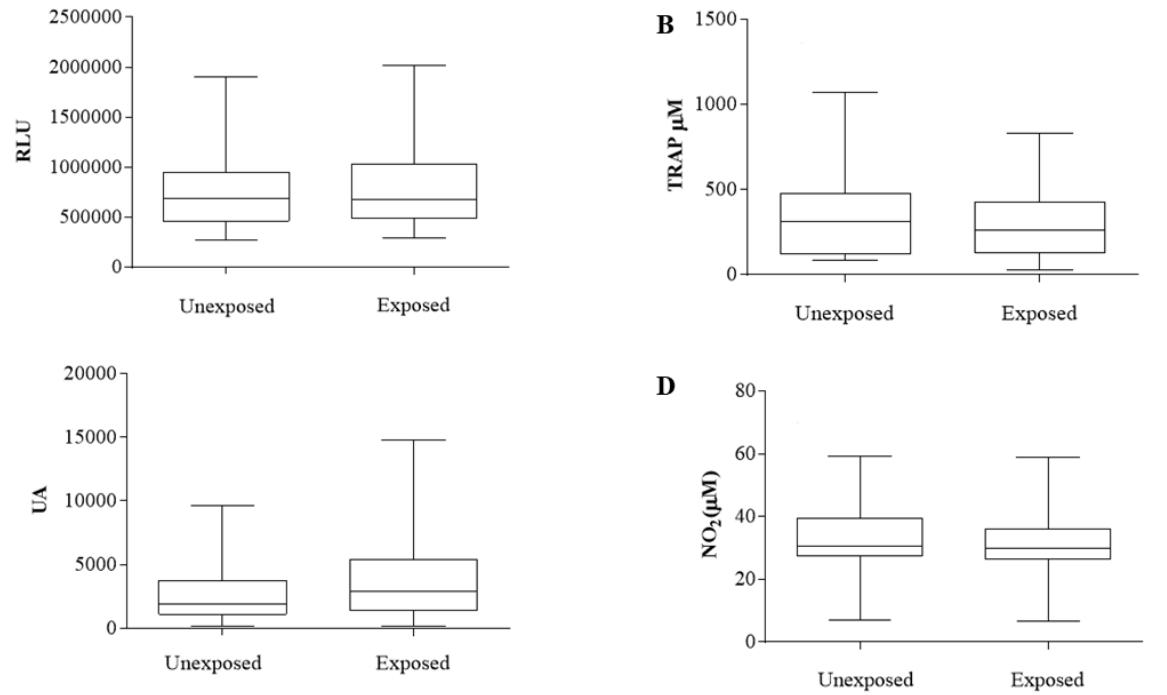
Figure 2. Oxidative stress analysis of plasma samples of exposed and unexposed breast cancer patients from intermediate-risk stratification. ( A ) Plasma hydroperoxide levels, measured in RLU = relative light units. ( B ) Total plasma antioxidant capacity (TRAP), measured in nM of Trolox. ( C ) Oxidation index in arbitrary units. ( D ) Levels of nitric oxide metabolites, measured in μM. Results are represented in box plots (min–max). * Indicates significant difference ( p < 0.05). Analyses were performed with GraphPad Prism 7.0 (GraphPad Software. San Diego, CA, USA).